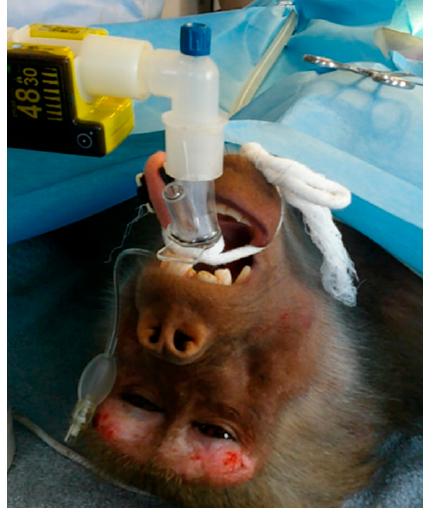
Figure 2. One of the baboons involved in the study after the insertion of the LMA device. The mainstream capnograph is connected to the LMA using an L connector.